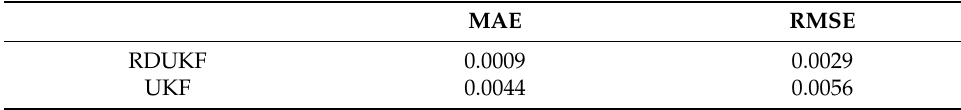
Table 2. Estimated error under the